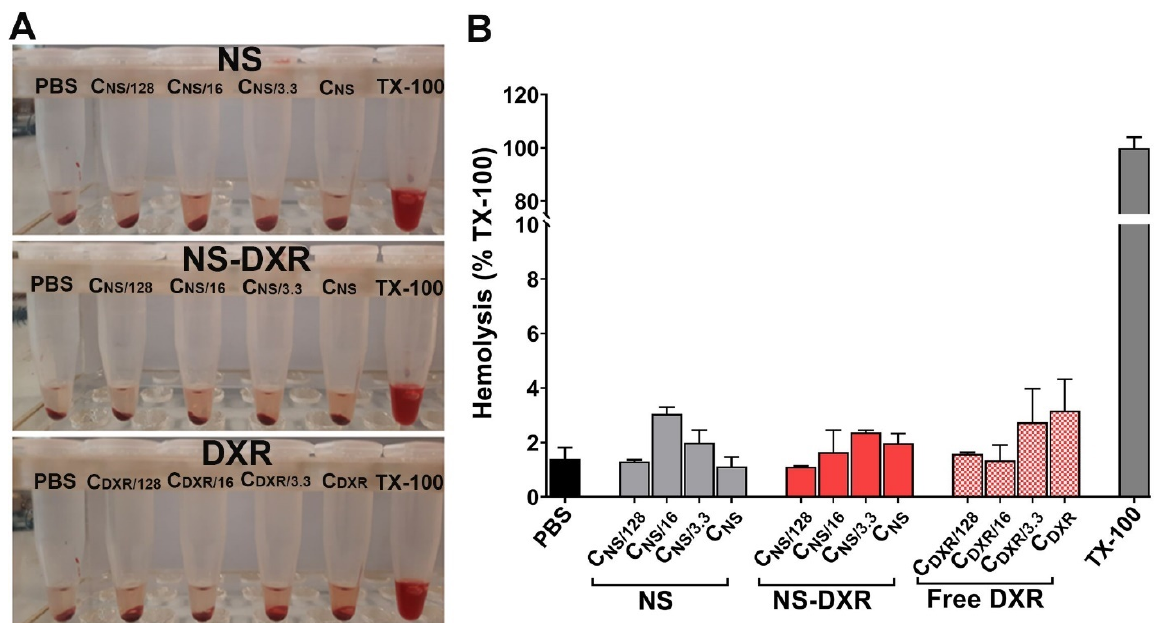
Figure 5. In vitro hemocompatibility evaluation of NS, NS-DXR, and DXR. ( A ) Photographs of the sedimented erythrocytes after their exposure to various concentrations of NS and NS-DXR (0.0078 ÷ 1 mg/mL, C NS = 1 mg/mL), and to the corresponding free DXR concentrations (0.156 ÷ 20 μ g/mL, C DXR = 20 μ g/mL). ( B ) Quantification of hemolysis by measuring the absorbance of hemoglobin at 540 nm. Results are expressed as means ± standard deviation (S.D.) of one experiment performed in duplicate.